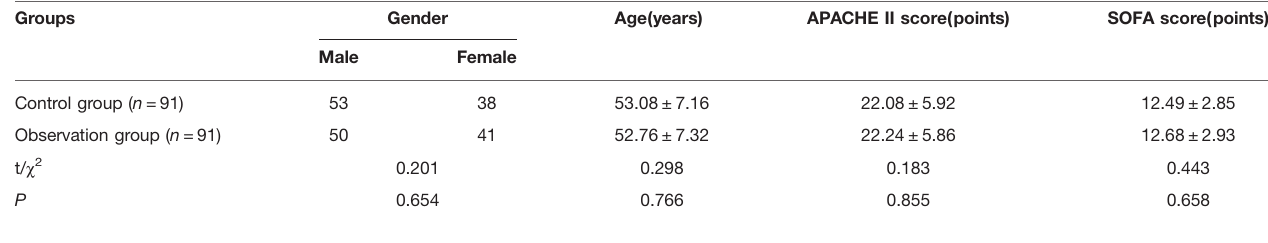
TABLE 1 | Comparison of general data between the two groups.